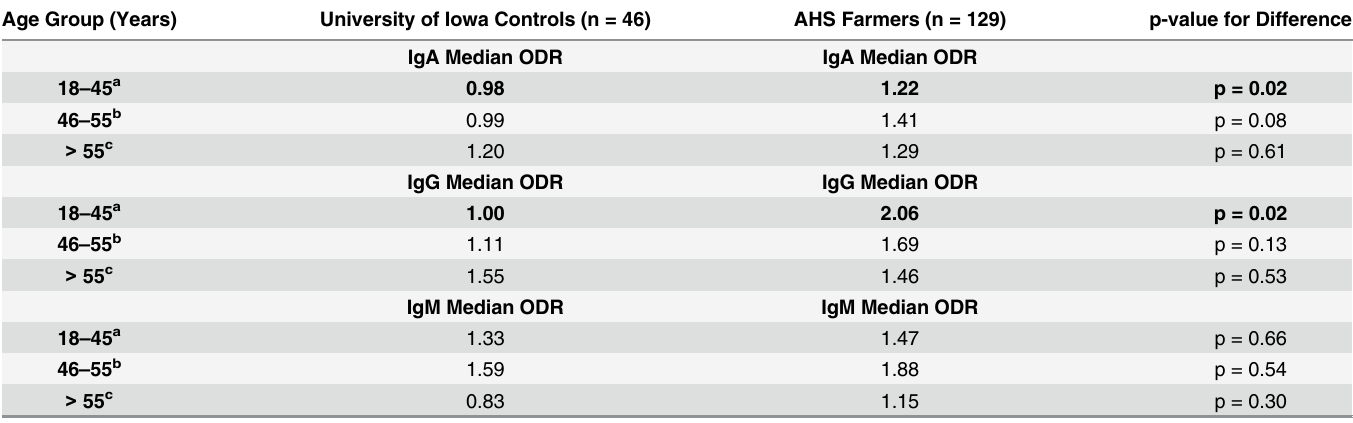
Table 3. Difference in Anti- C . jejuni Optical Density Ratio Distribution Between Farmers and Controls by Age Category (n = 175). Age Group